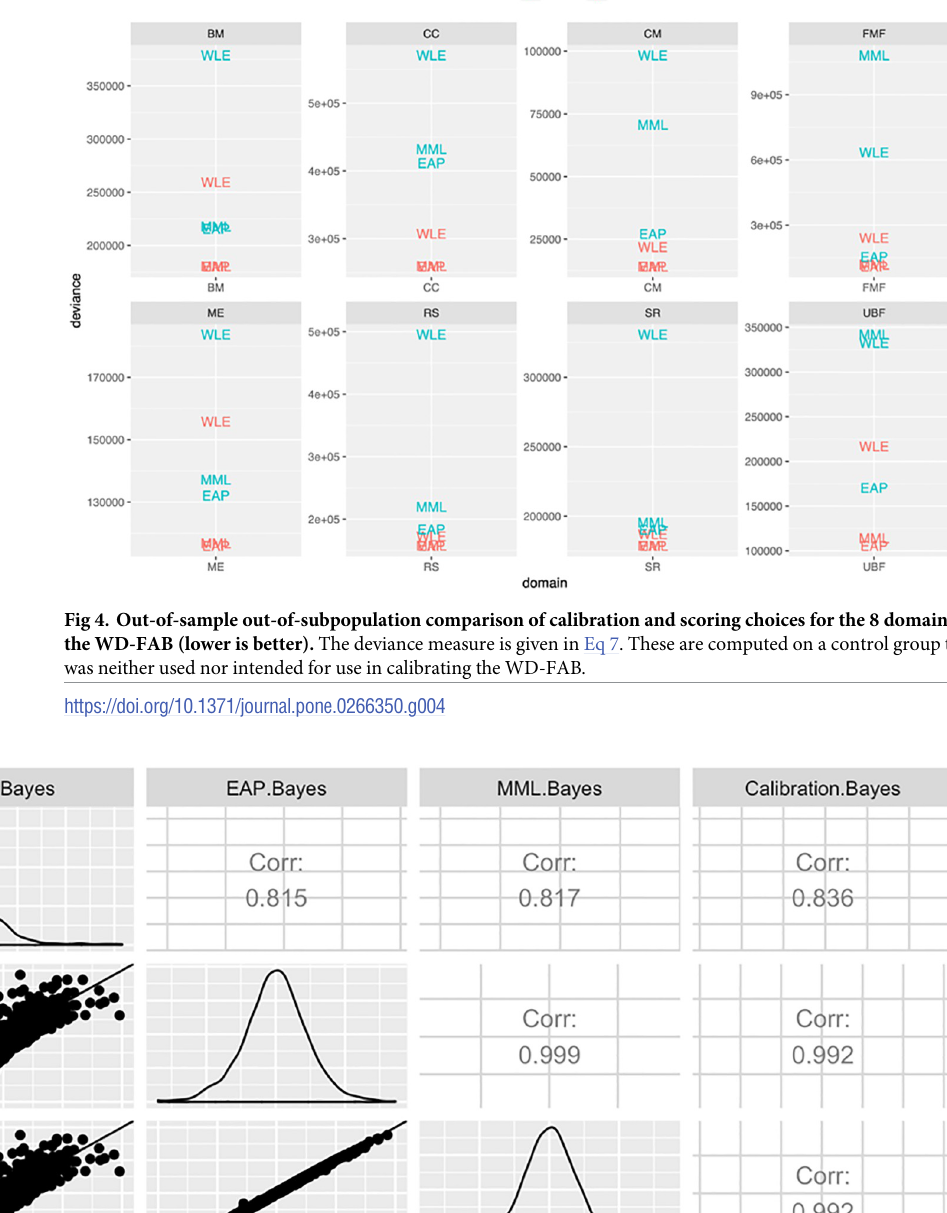
PLOS ONE | https://doi.org/10.1371/journal.pone.0266350 April 8,